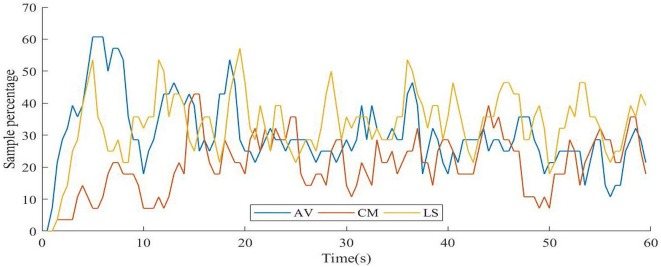
Sample percentage of response on each second. AV, adventure video; CM, comedy video; LS, landscape video.